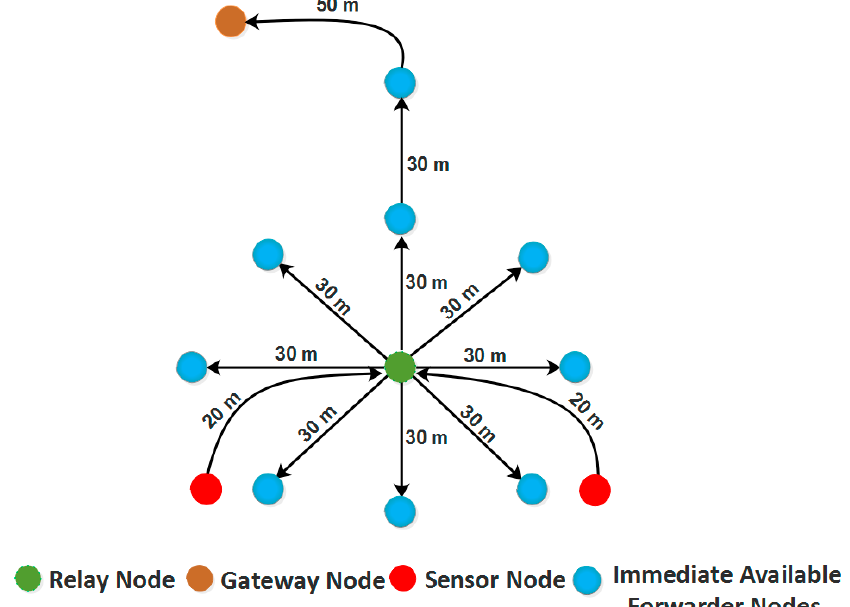
Figure 1. Mechanism of choosing the Immediate Available Forwarder Nodes (I AFN ), adjusted by the proposed scheme ROBINA with the help of relay nodes and gateway nodes.